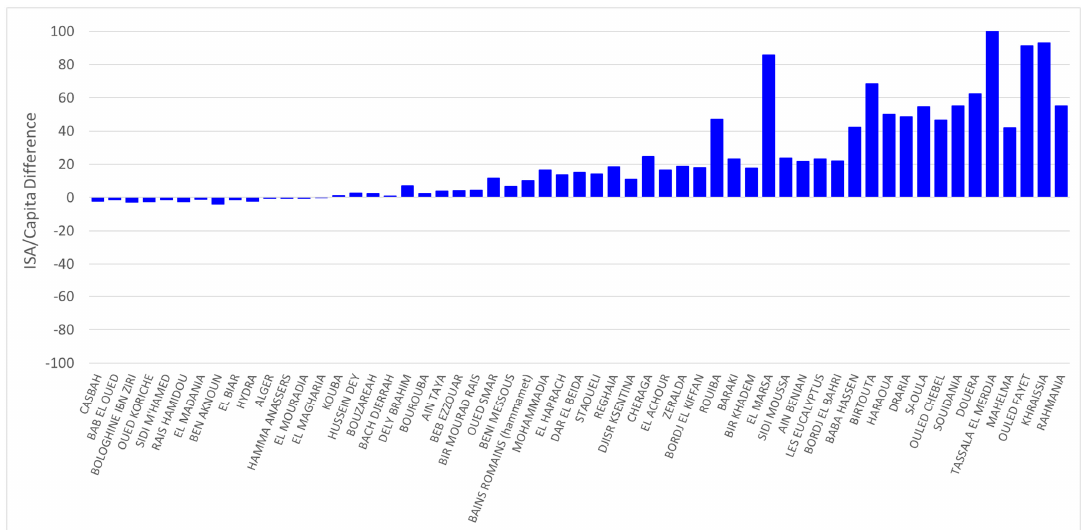
Figure 15. Difference of impervious surface area per capita (m 2 /person) for the communes in the Algiers wilaya between 2008 and 2018.